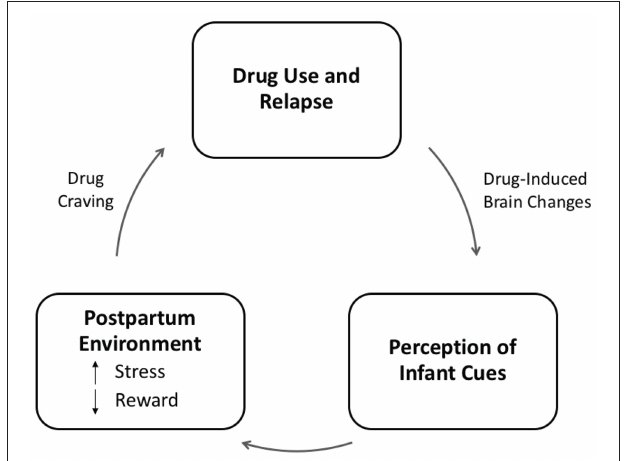
FIGURE 2 | Model of the relation between addiction and parenting adapted from Rutherford et al. (11). In this model, addiction represents the dysregulation of stress and reward systems, both of which are adapted to support parenting. In the case of addiction, we propose that drug-induced brain changes result in the attenuation of the reward value of infant cues, which are replaced by a more stressful neurophysiological response. This stress response to infant cues may increase craving for drugs and promote drug seeking and relapse in abstinent mothers, thus perpetuating a cycle of